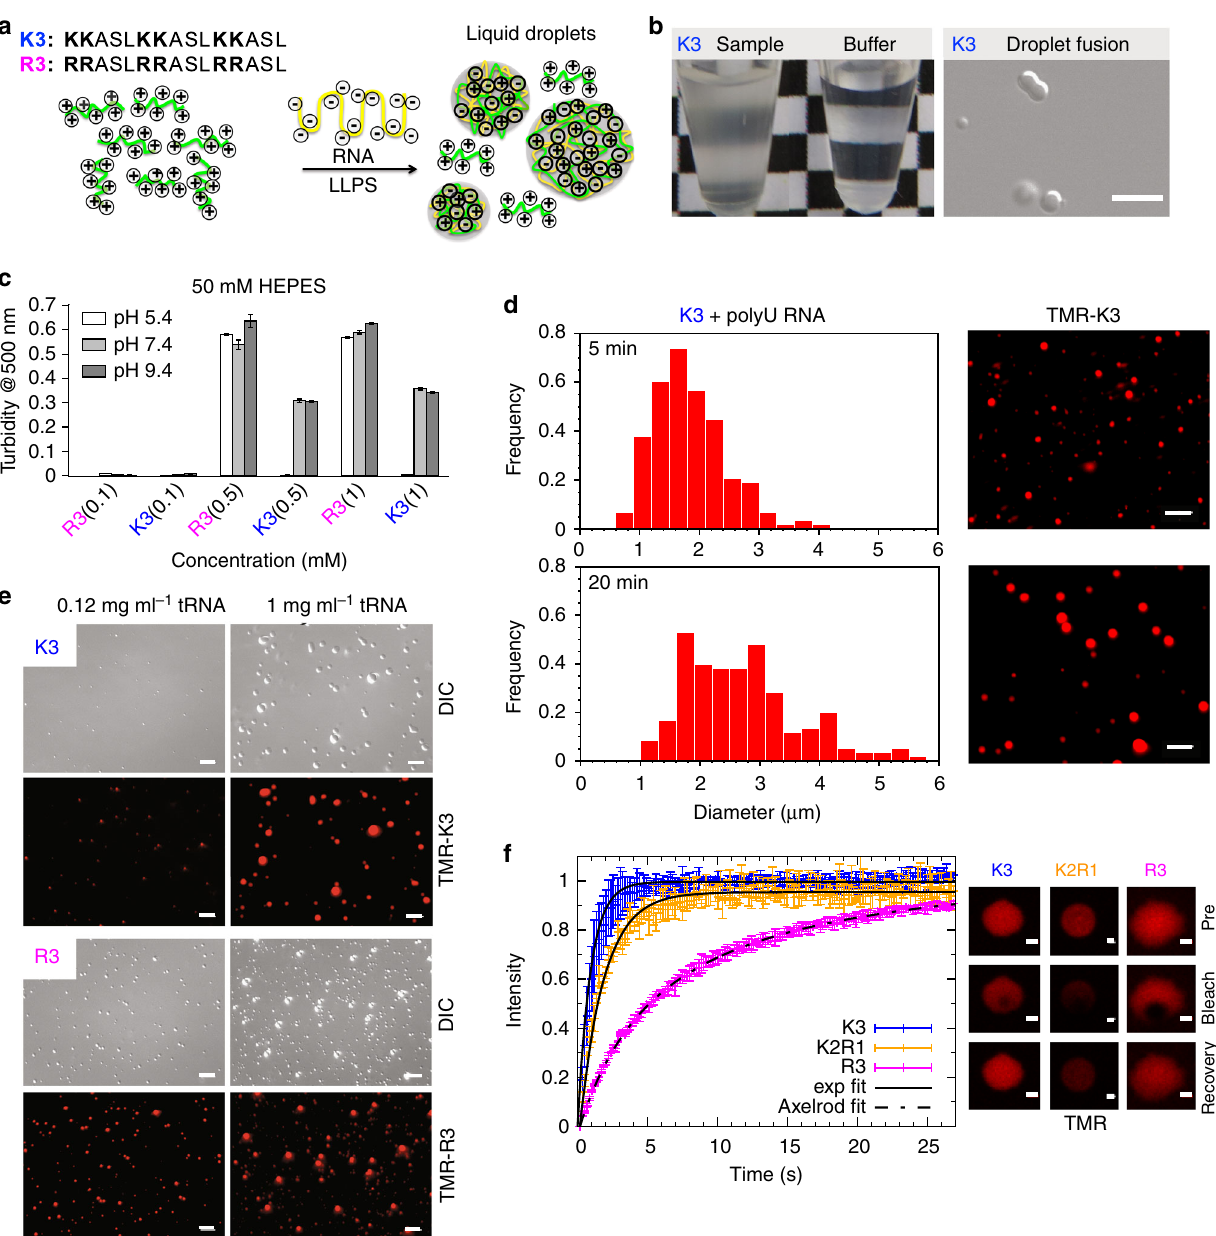
Fig. 2 Complex coacervation of lysine-rich polypeptides. a Amino acid sequences of the lysine-rich (K3) and arginine-rich peptide (R3) along with a schematic of complex coacervation upon addition of RNA. b (left) Comparison of the turbid (phase-separated) peptide-containing sample and the control sample/buffer. (Right) DIC image of a pair of K3/RNA liquid droplets undergoing fusion. The concentration of polyU RNA was 0.5 mg ml − 1 and K3 was 1 mM. c Turbidity of K3 with tRNA (0.5 mg ml − 1 ) and R3 with tRNA (0.5 mg ml − 1 ) samples at different pH values and peptide concentrations (0.1 mM, 0.5 mM, and 1 mM). Reported turbidity values represent the average of a triplicate of measurements for each sample. d Distribution of droplet diameters after 5 and 20 min with the corresponding fl uorescence images. The concentration of polyU RNA was 1 mg ml − 1 . e DIC and fl uorescence images depicting the tRNA concentration-dependence of K3 (top) and R3 (bottom) coacervation. Scale bars, 10 μ m. f Normalized FRAP recovery curves (left) for K3/RNA- coacervates, K2R1/RNA-coacervates and R3/RNA-coacervates with the corresponding FRAP images (right; recovery image 27.2 s after bleaching; scale bar 1 μ m). Fits to the experimental data assuming an exponential recovery (K3, K2R1; solid line) and diffusion-controlled recovery (R3; Axelrod model, dash-dotted line). The concentration of K3, K2R1, R3, and polyU RNA in DIC, fl uorescence imaging, and FRAP were identical and equal to 1 mM K3/K2R1/ R3 and 1 mg ml − 1 polyU RNA, in 50 mM HEPES, pH 7.4. TMR-K3, TMR-K2R1 and TMR-R3 were used as speci fi ed in the methods section. Error bars in c and f correspond to ± SD. Source data are provided as a Source Data fi 0.63 s (Fig. 2f) with a BIC(exponential) = − 821, whereas BIC repeat, and formed droplets through addition of RNA. FRAP (Axelrod) = − 652. To provide further support for the distinct analysis showed that the kinetics of fl uorescence recovery are in- diffusional properties of lysine and arginine-rich polypeptide between those of K3 and R3 (Fig. 2f). In addition, the recovery sequences in RNA-mediated droplets, we prepared the hybrid kinetics of K2R1 were better described by an exponential recovery peptide K2R1, which consists of two KKASL and one RRASL with a half time of 1.2 s (BIC(exp) = − 635), whereas an Axelrod